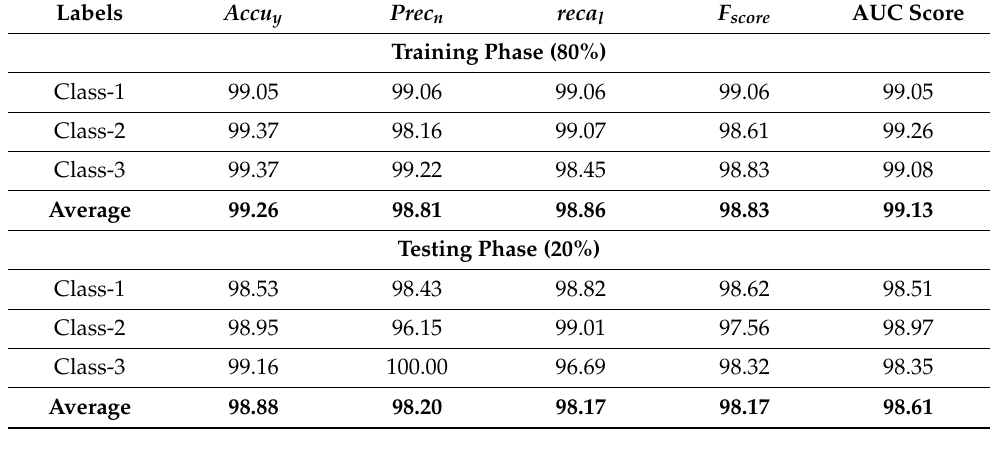
Table 2. Result analysis of MRFOTL-GCDC system at an 80:20 ratio of the TR/TS database.